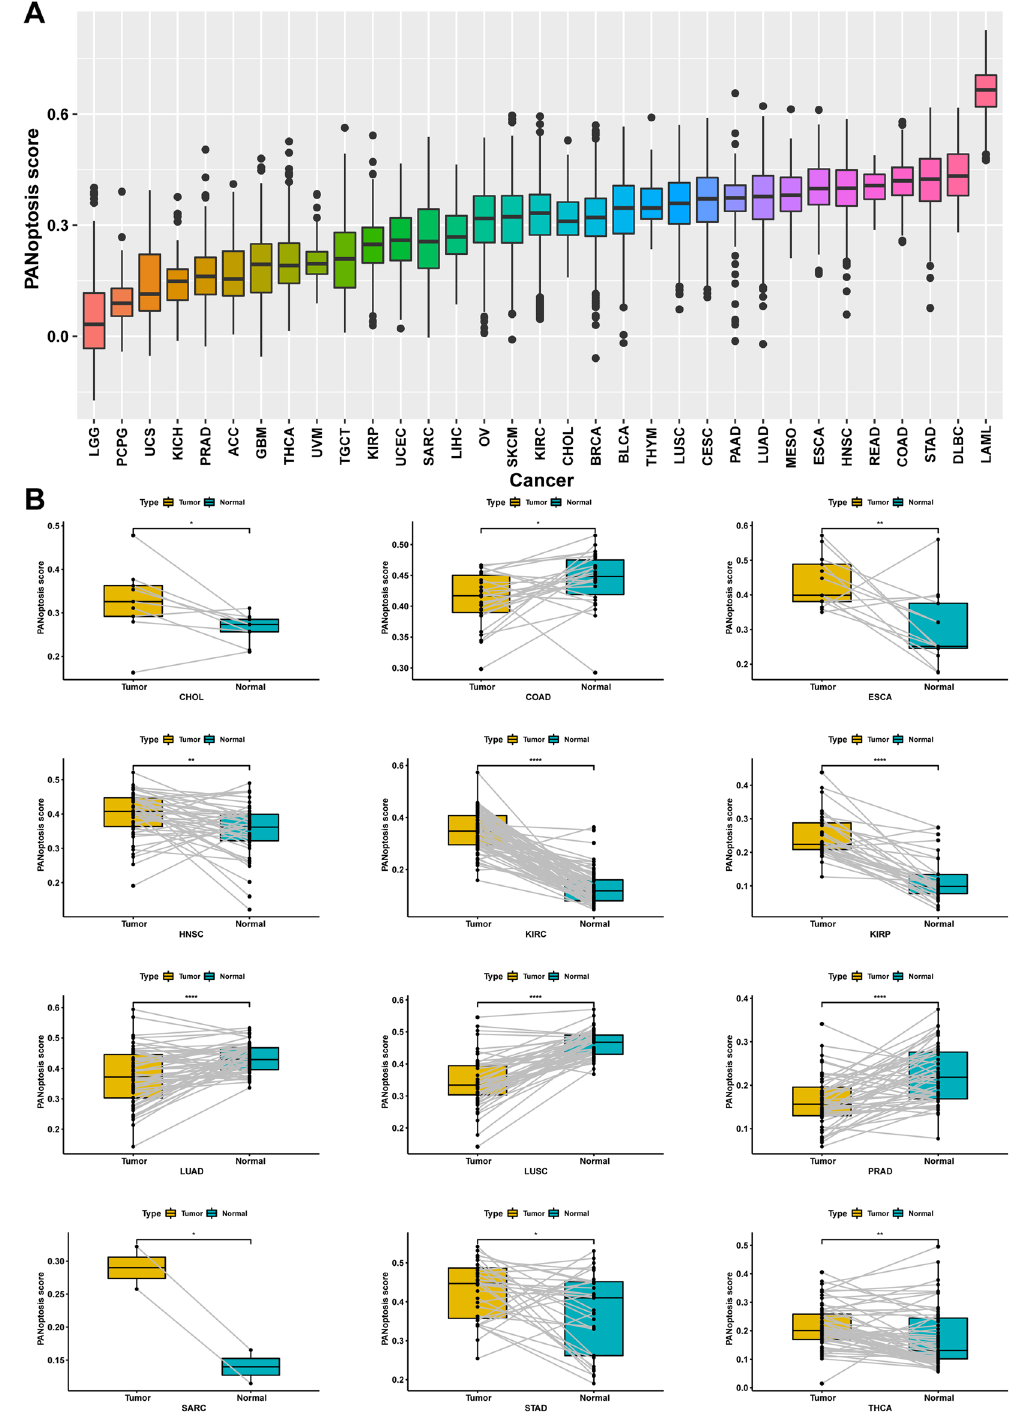
Figure 6. The distribution of PANoptosis score. ( A ) The PANoptosis score in each cancer type. ( B ) Comparison of the PANoptosis scores in tumor and corresponding normal tissues based on TCGA